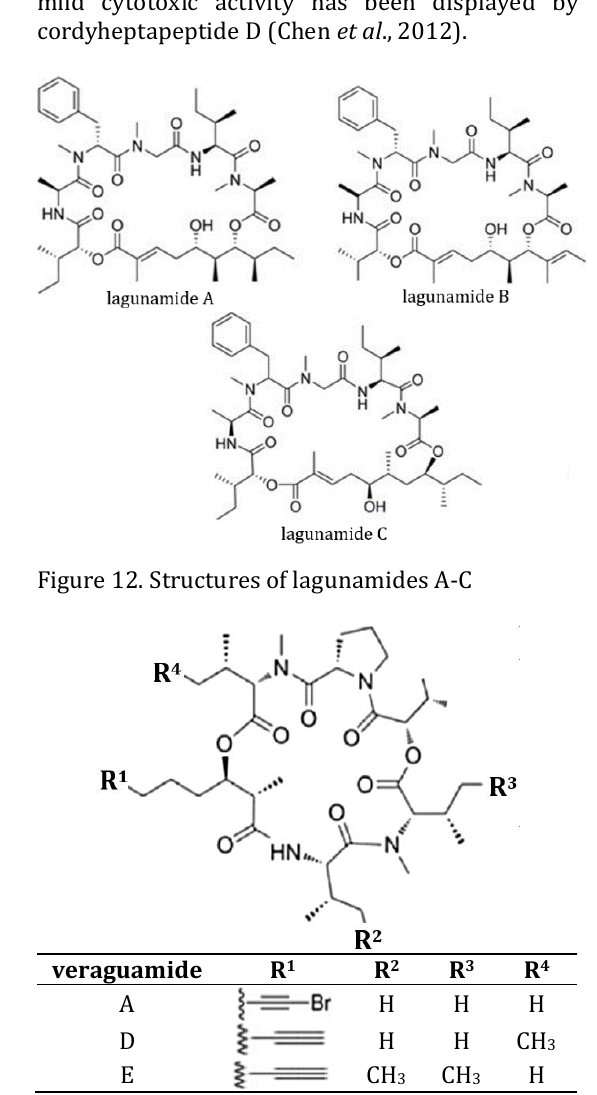
Figure 13. Structure of